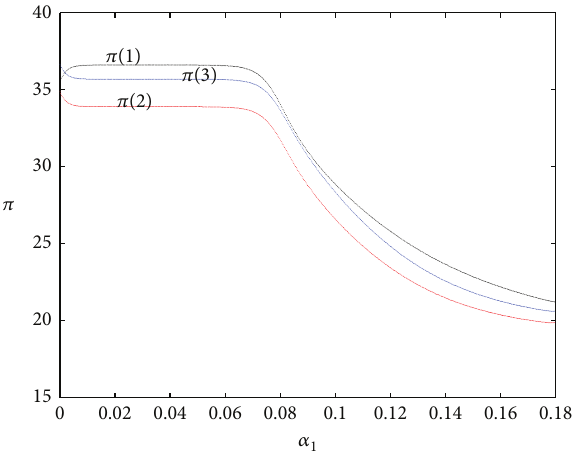
Figure 10: Track figure of profit with 𝛼 1 .